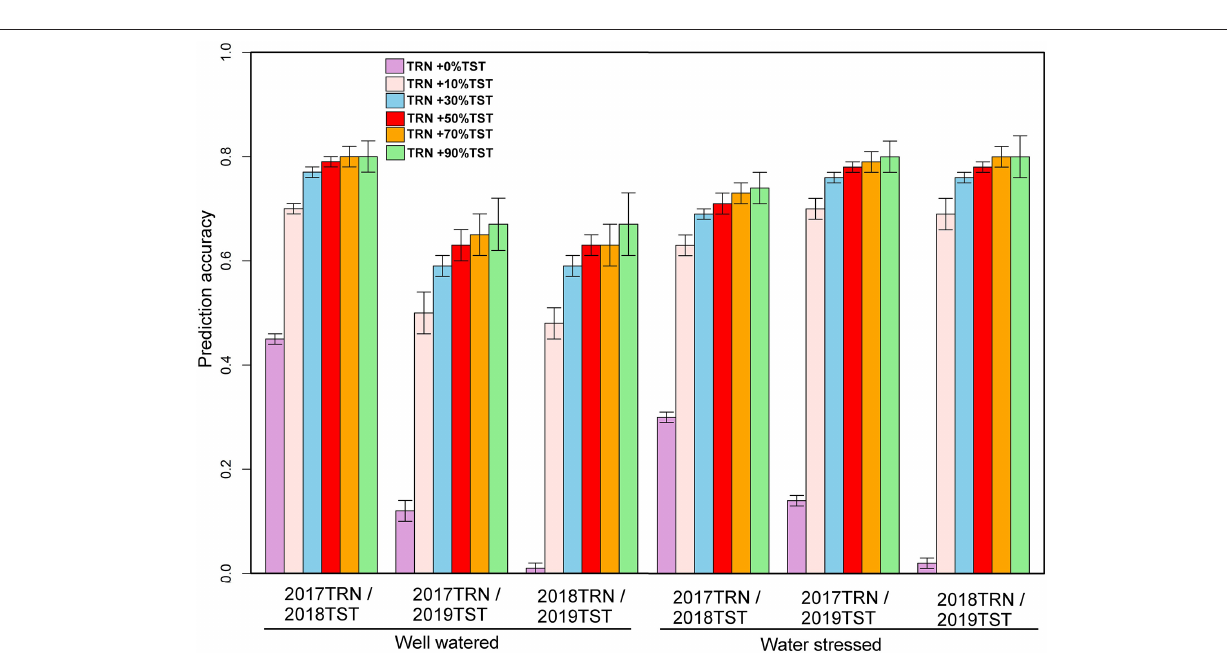
In this study, we used large data sets of 3,068 DH lines genotyped and phenotyped as test crosses across 3 years in WW and WS conditions in Kenya to evaluate the potential of genomic